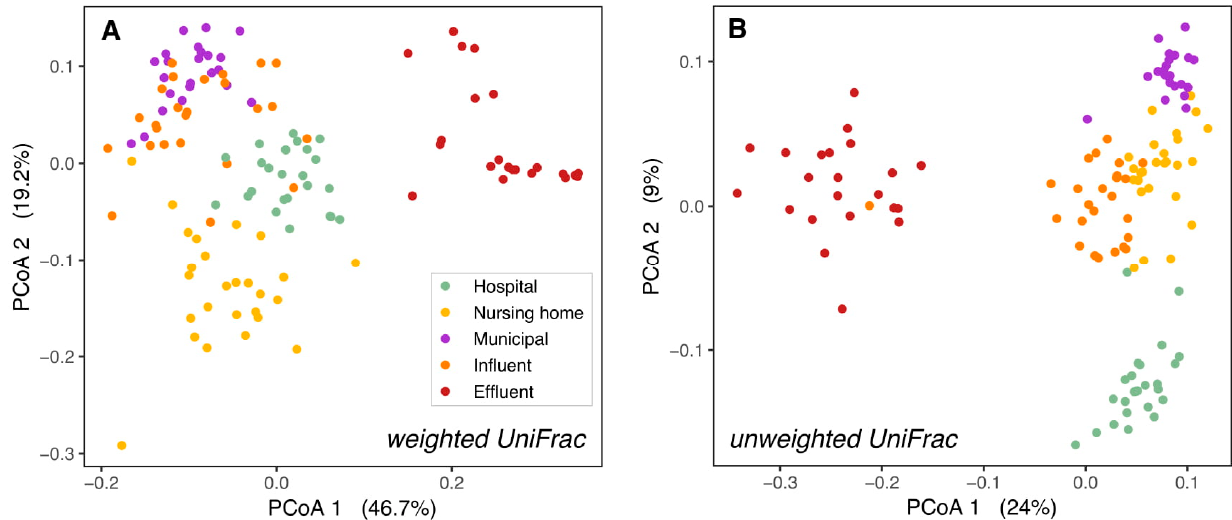
Figure 1. Bacterial ß-diversity along the wastewater pathway. Principal coordinates ordination of different wastewaters based on weighted UniFrac distances ( A ) and unweighted UniFrac distances ( B ). 66% of the diversity in bacterial composition and 39% of the diversity in bacterial membership could be explained by the locations. The percentage of variation explained by each axis is shown between parentheses. H = hospital, N = nursing home, M = municipal, I = influent, E = effluent. While communities from the hospital, nursing home, and domestic wastewater formed separate clusters, they clustered more closely to WWTP influent than to effluent or surface water. This held true both for the relative abundances of taxonomic groups